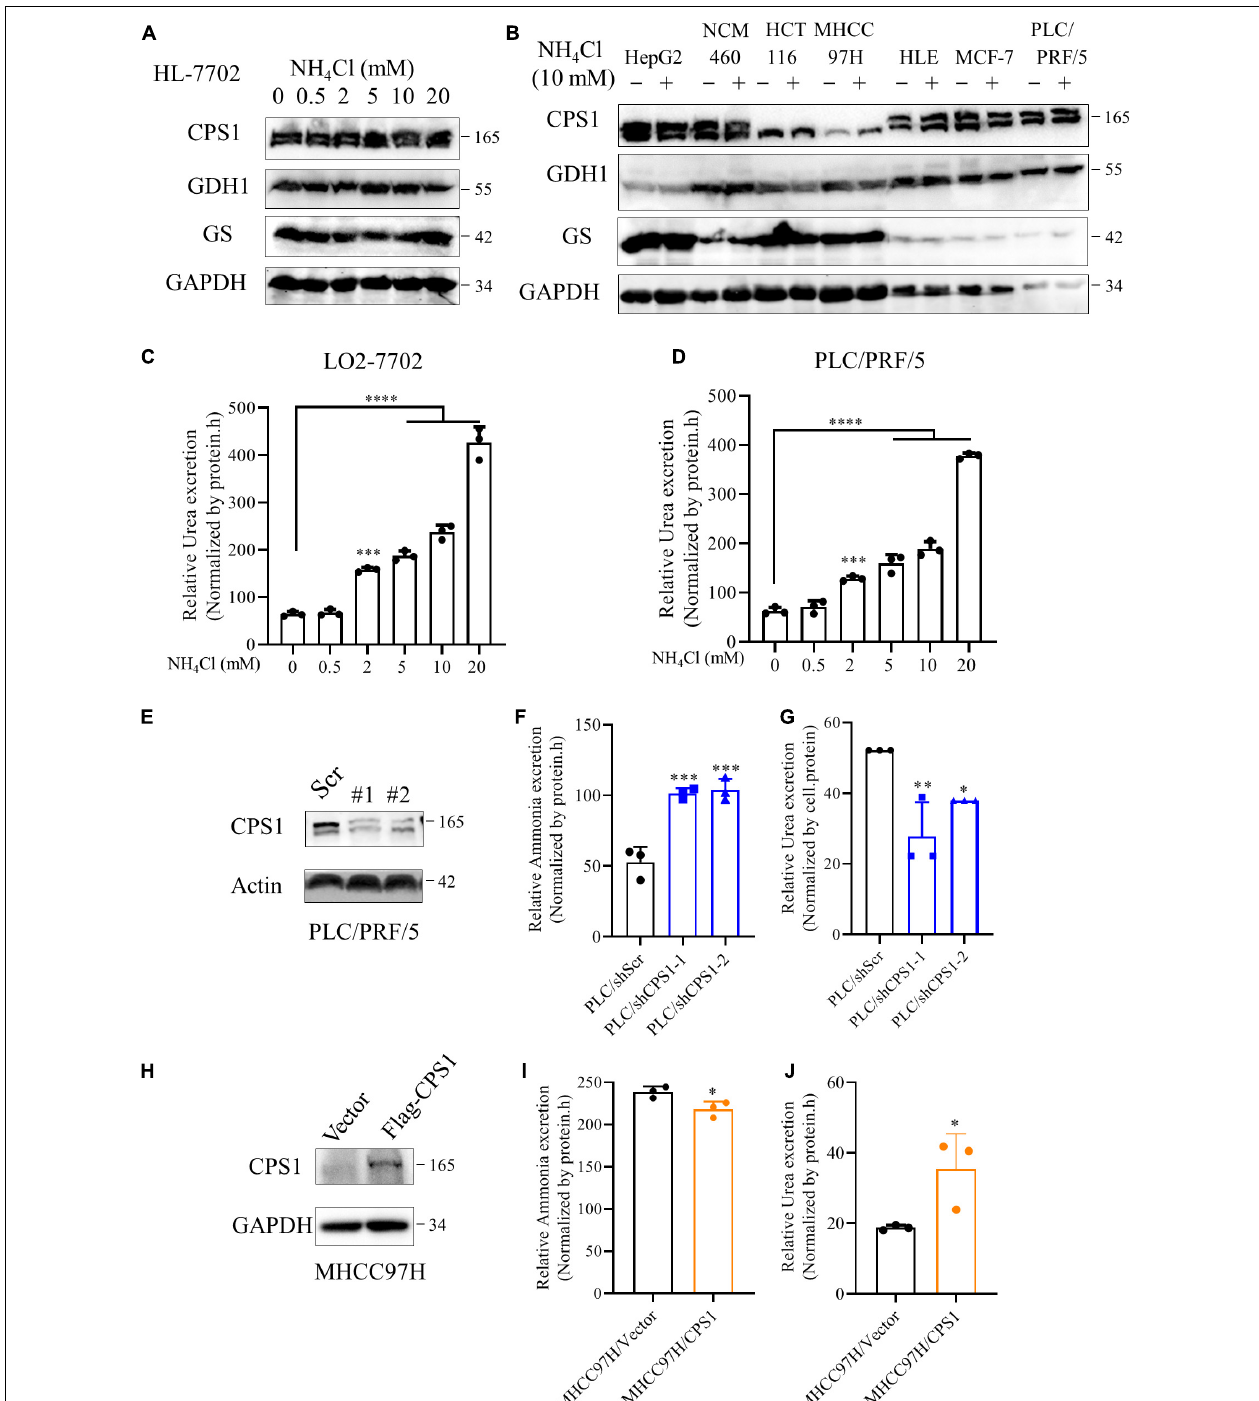
FIGURE 6 | The relationship of urea cycle with ammonia metabolism in cancer cells. (A) Western blot of lysates from HL-7702 cells cultured under 0, 0.5, 2, 5, 10 or 20 mM NH 4 Cl for 8 h. (B) Western blot of lysates from HepG2, NCM460, HCT116, MHCC97H, HLE, MCF-7, PLC/PRF/5 cells cultured under 0 or 10 mM NH 4 Cl for 8 h. (C,D) Relative urea excretion from HL-7702 and PLC/PRF/5 cells cultured under 0, 0.5, 2, 5, 10 or 20 mM NH 4 Cl for 48 h. (E) Western blot confirmed the knockdown of CPS1 in PLC/PRF/5 cells. (F) Relative ammonia excretion in PLC/PRF/5/shScramble, PLC/PRF/5/shCPS1 for 8 hours. (G) Relative urea excretion in PLC/shScr, PLC/shCPS1 for 48 h. (H) Western blot confirmed the over-expression of CPS1 in MHCC97H cells. (I) Relative ammonia excretion in MHCC97H/Vector, MHCC97H/CPS1 for 8 h. (J) Relative urea excretion in MHCC97H/Vector, MHCC97H/CPS1 for 48 h. Values are the means ± SD of three independent experiments. ∗ p < 0.05; ∗∗ p < 0.01, ∗∗∗ p < 0.001, ∗∗∗∗ p < 0.0001.